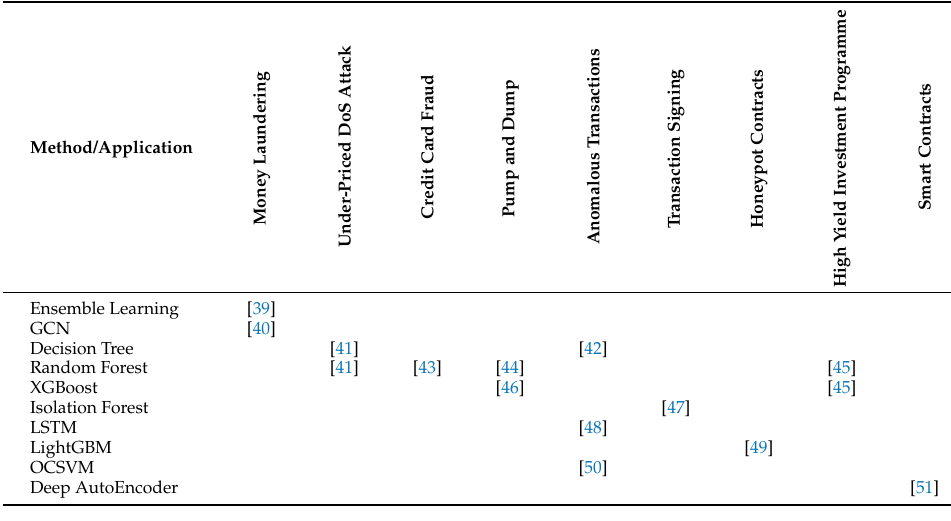
Table 3. Financial Anomaly